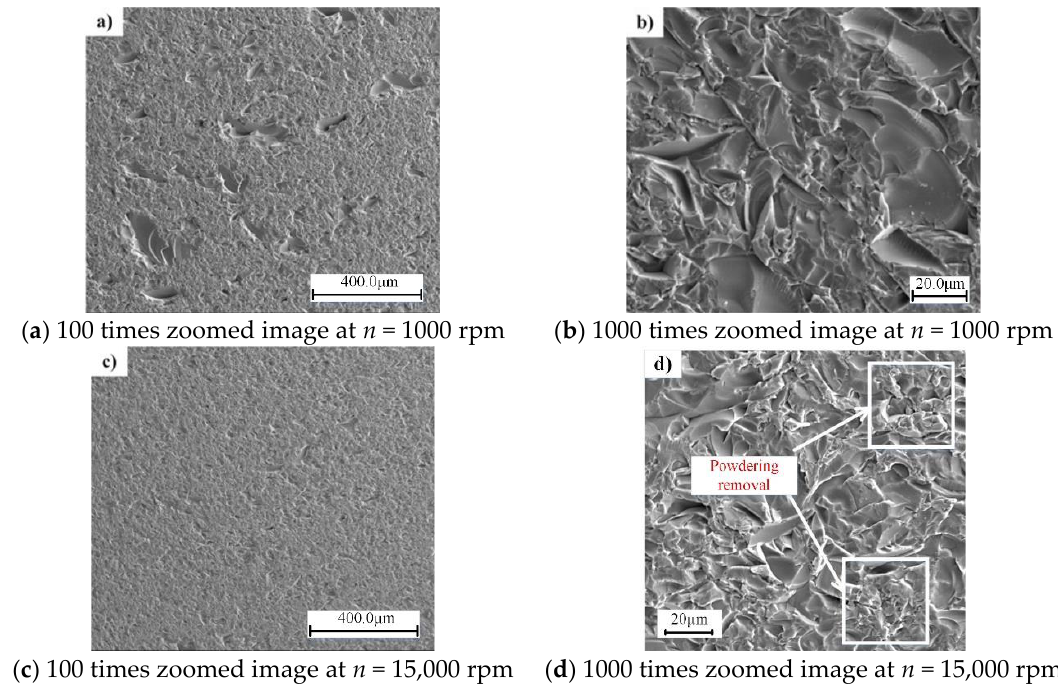
Figure 2. Machined surface morphologies of optical glass at different spindle rotation speed.